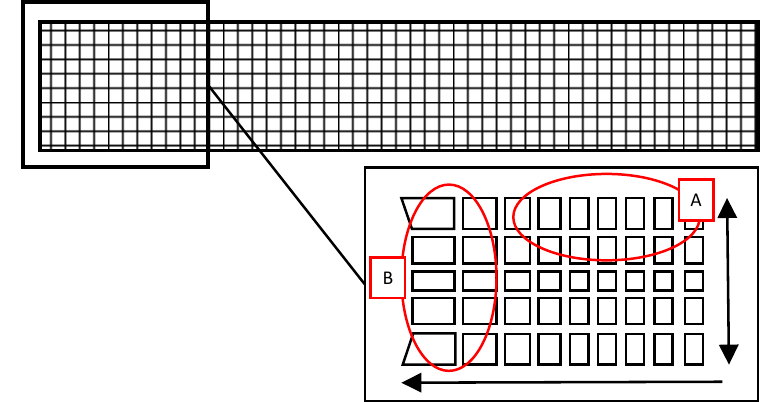
Figure 8. Schematic of a 2D projection of a log via equal pixels and the expected described log surface with ( A ) longer areas towards the outside and ( B ) wider areas towards the extremities of the pictured log. The arrows indicate the direction of exceeding surface areas defined by a single pixel.